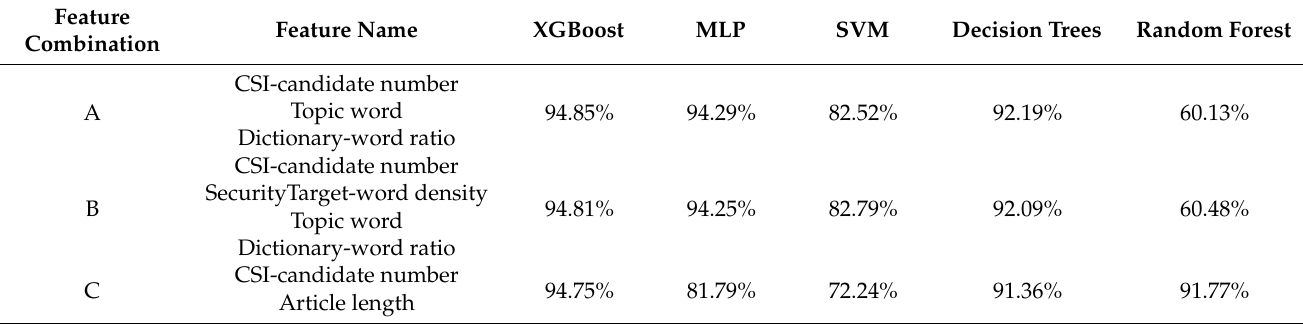
Table 7. Classification accuracy of five classifiers with different feature